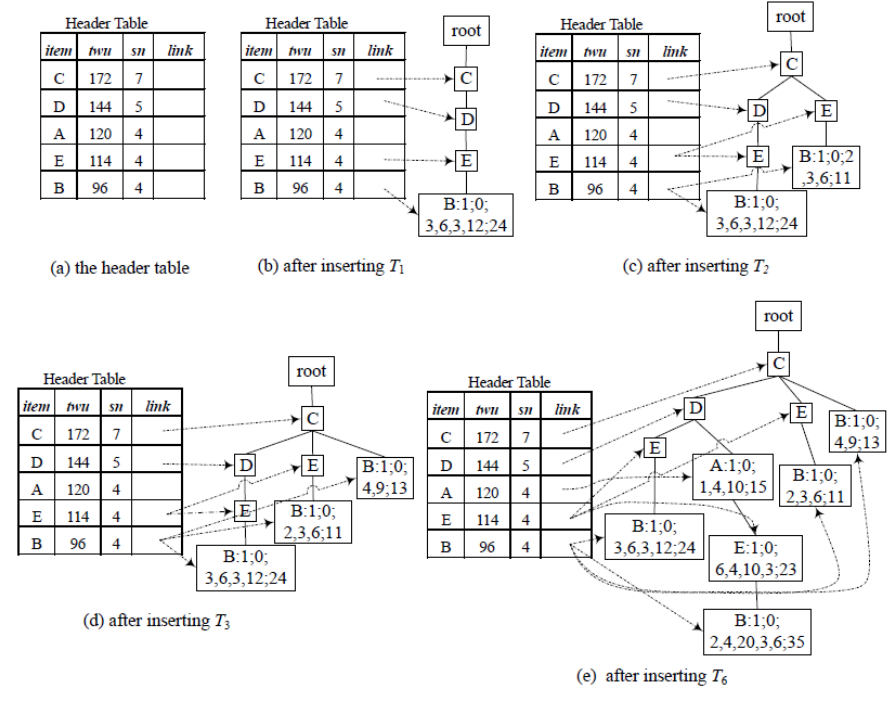
Figure 2. Construction of a